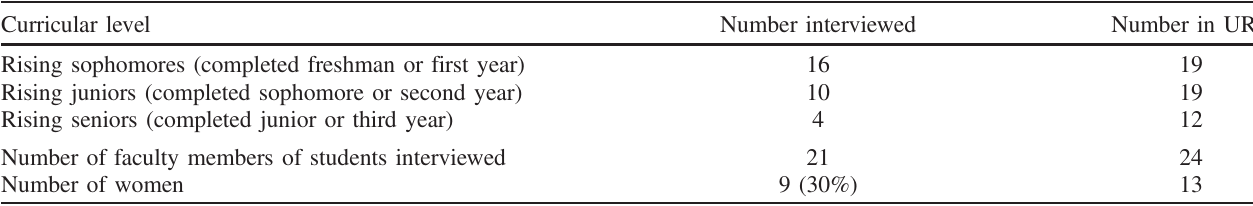
TABLE I. Demographics of the sample of students included in the